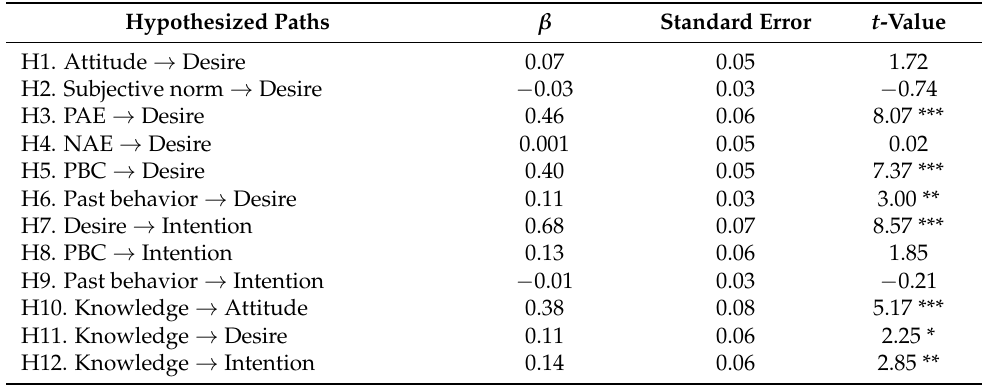
Table 2. Results of the hypothesized